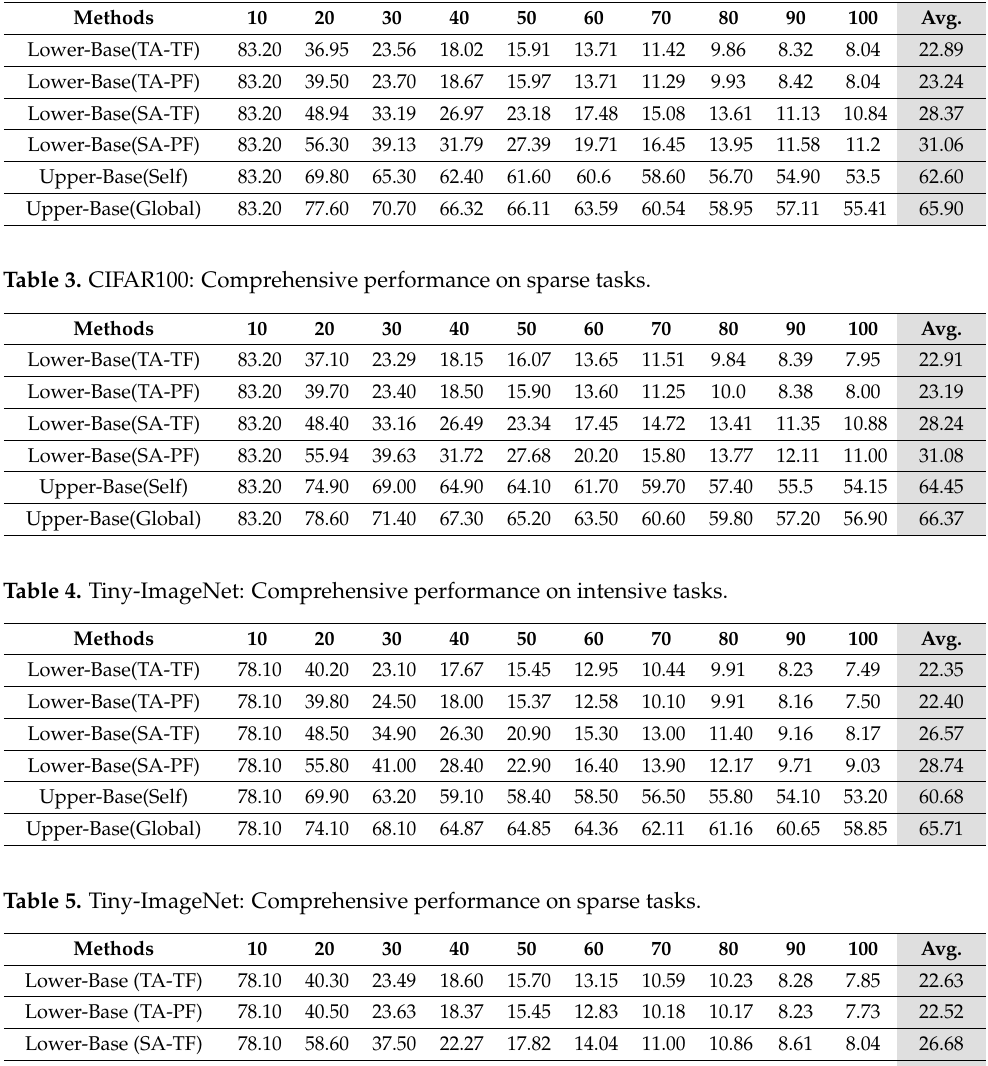
Table 2. CIFAR100: Comprehensive performance on intensive tasks.